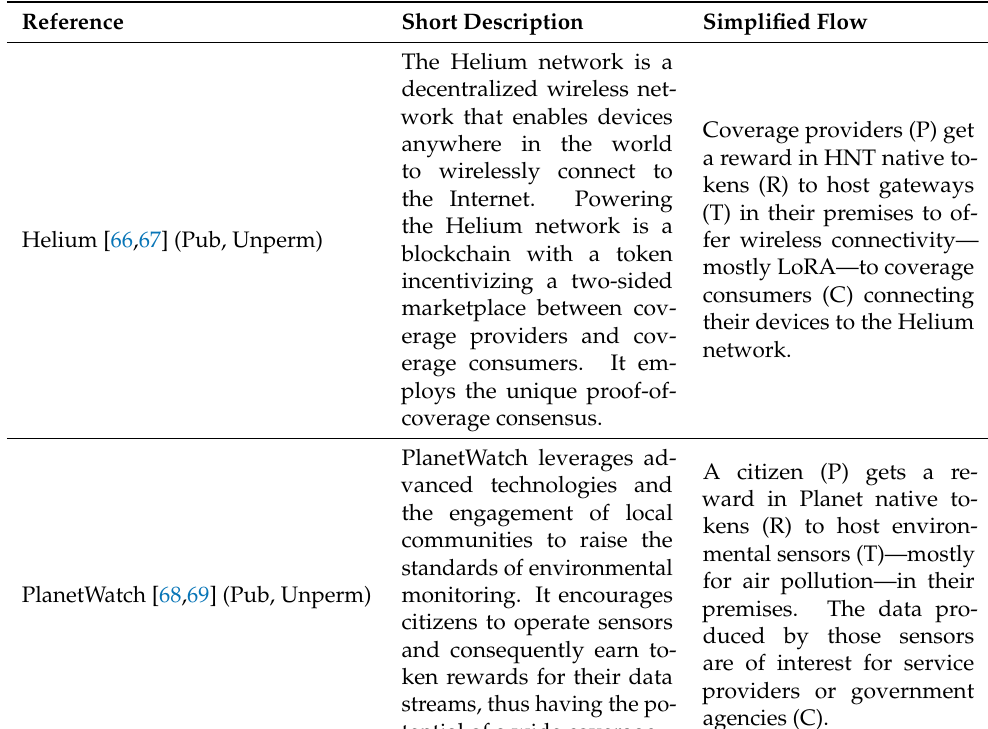
Table 3. A list of some prominent examples of applications or projects involving an IoT economy. For each mentioned application, the table indicates whether it is based on a public (Pub) or private (Priv) and permissioned (Perm) or unpermissioned (Unperm) blockchain. In the column “simplified flow”, we emphasize the thing (T), the producer (P), the consumer (C), and the reward